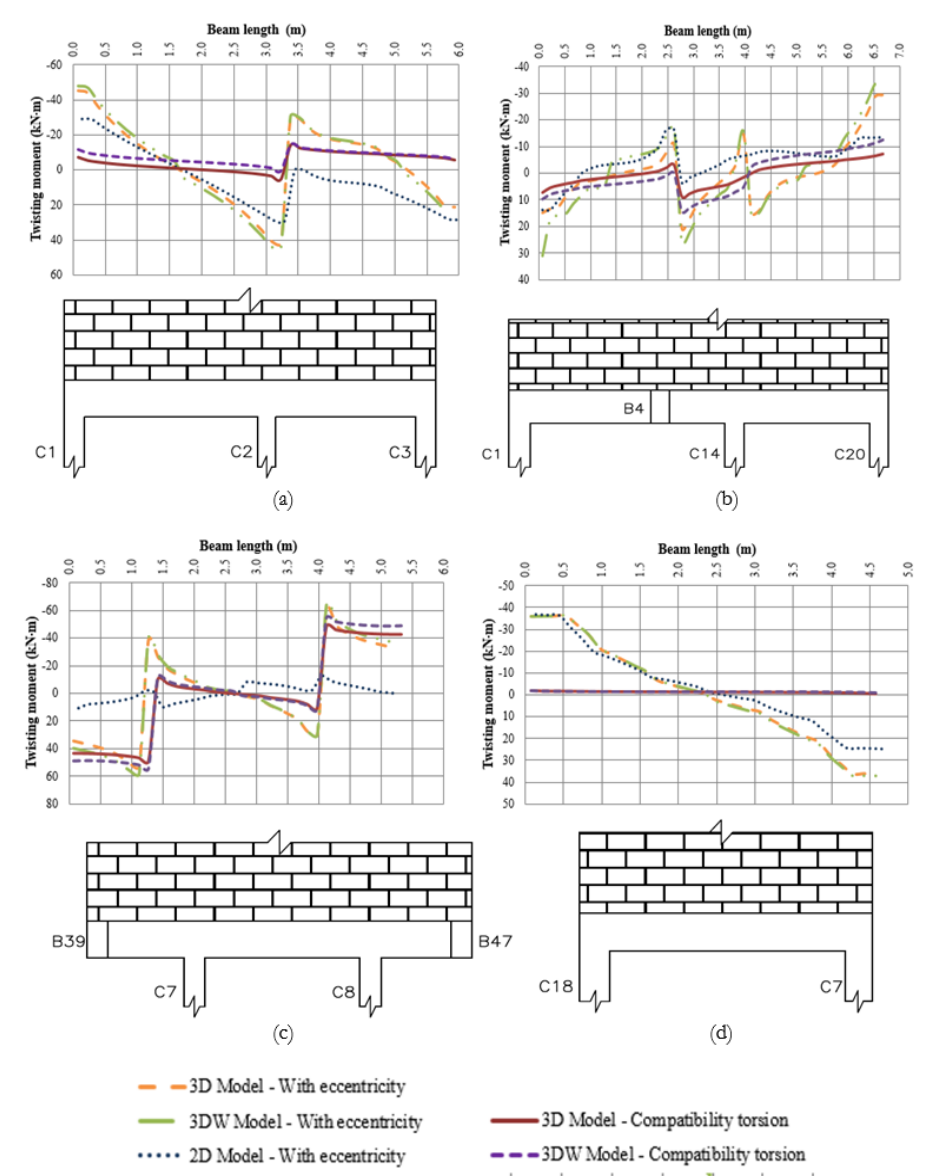
Figure 17. Twisting moments in reinforced concrete support beams: (a) Wall 1; (b) Wall 30; (c) Wall 3; (d) Wall